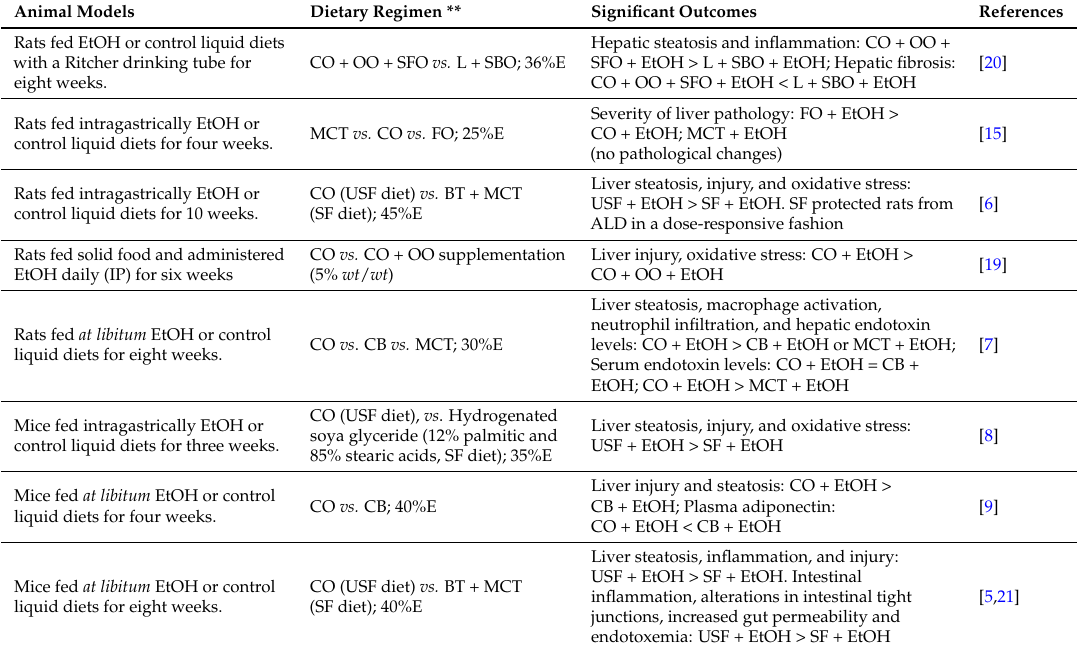
Table 1. The overall effects of different types of dietary fat on EtOH-mediated changes in the intestine and the liver *.